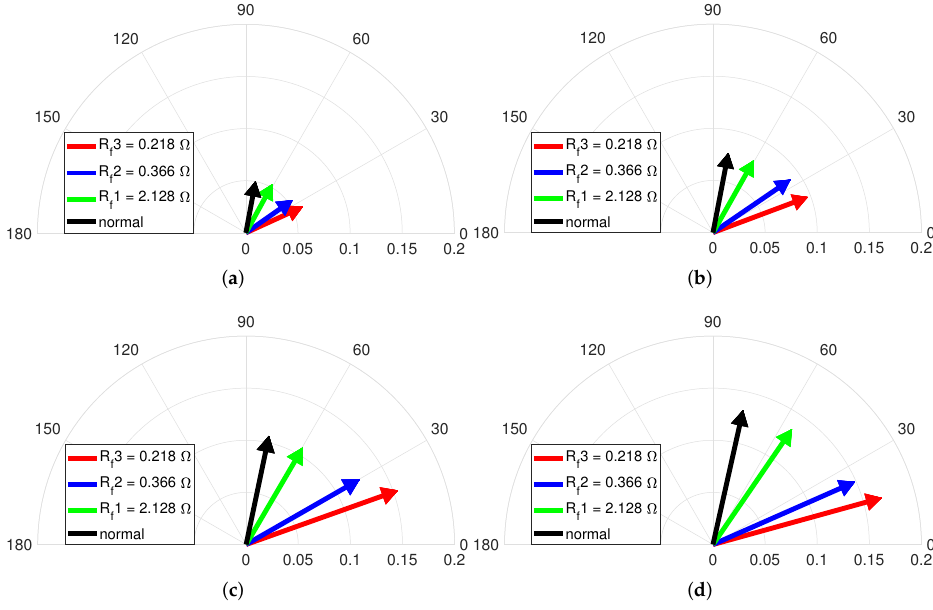
Figure 11. Vector diagram at ( a ) 2000, ( b ) 3000, ( c ) 4000, and ( d ) 4500 rpm and no-load with R f . Figure 12 depicts the vector diagrams by the combination of the magnitude and phase indicators under 4.5 Nm and varying speeds. The fault condition is composed of µ 1 = 0.042, µ 2 = 0.083 and µ 3 = 0.125 for fixed maximum R f = 2.128 Ω . The black-colored vector in Figure 12a represents the normal case, and the other vectors indicate the ITSF cases.